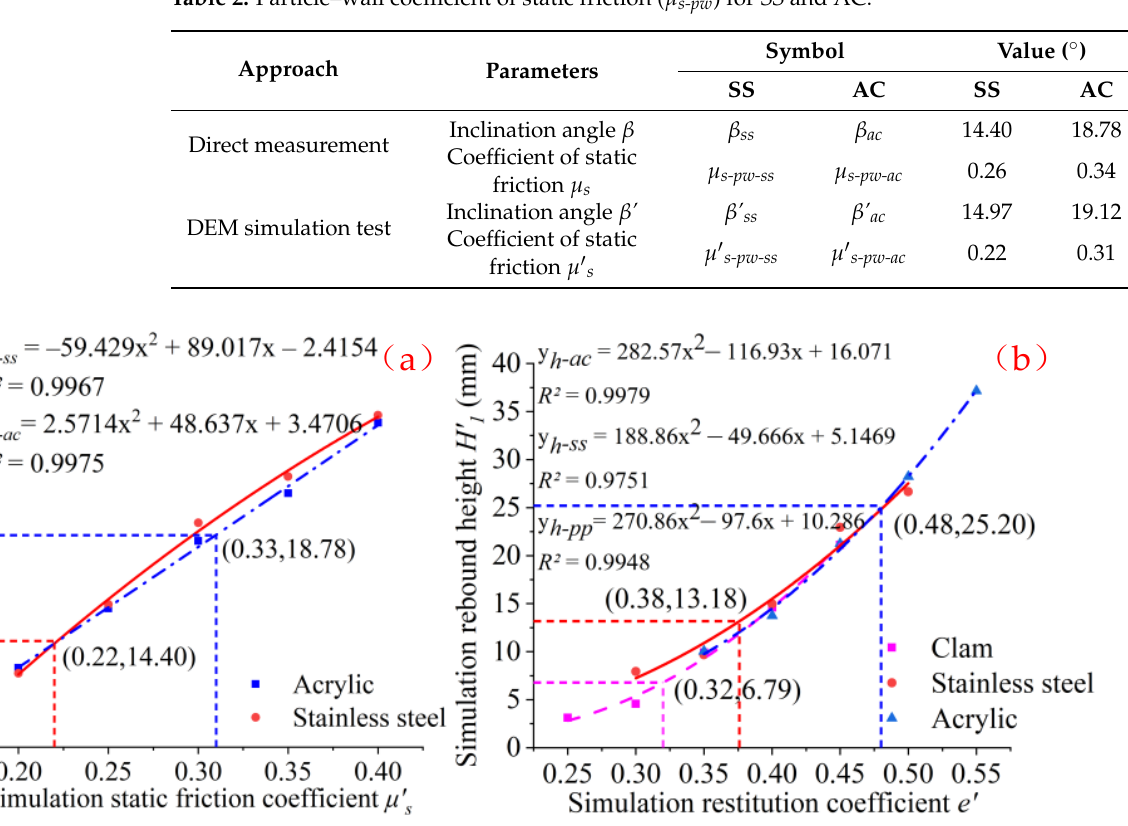
Figure 6. DEM simulation calibration fitting curve and equation of relation ( a ) simulation static friction coefficient and inclination angle ( b ) simulation restitution coefficient and rebound height. In the Figure, the ordinate of the coordinates located by the dotted line represents the realistic value of direct measurements, and the abscissa represents the calculated simulation contact parameters. Table 2. Particle–wall coefficient of static friction ( μ s-pw ) for SS and AC.